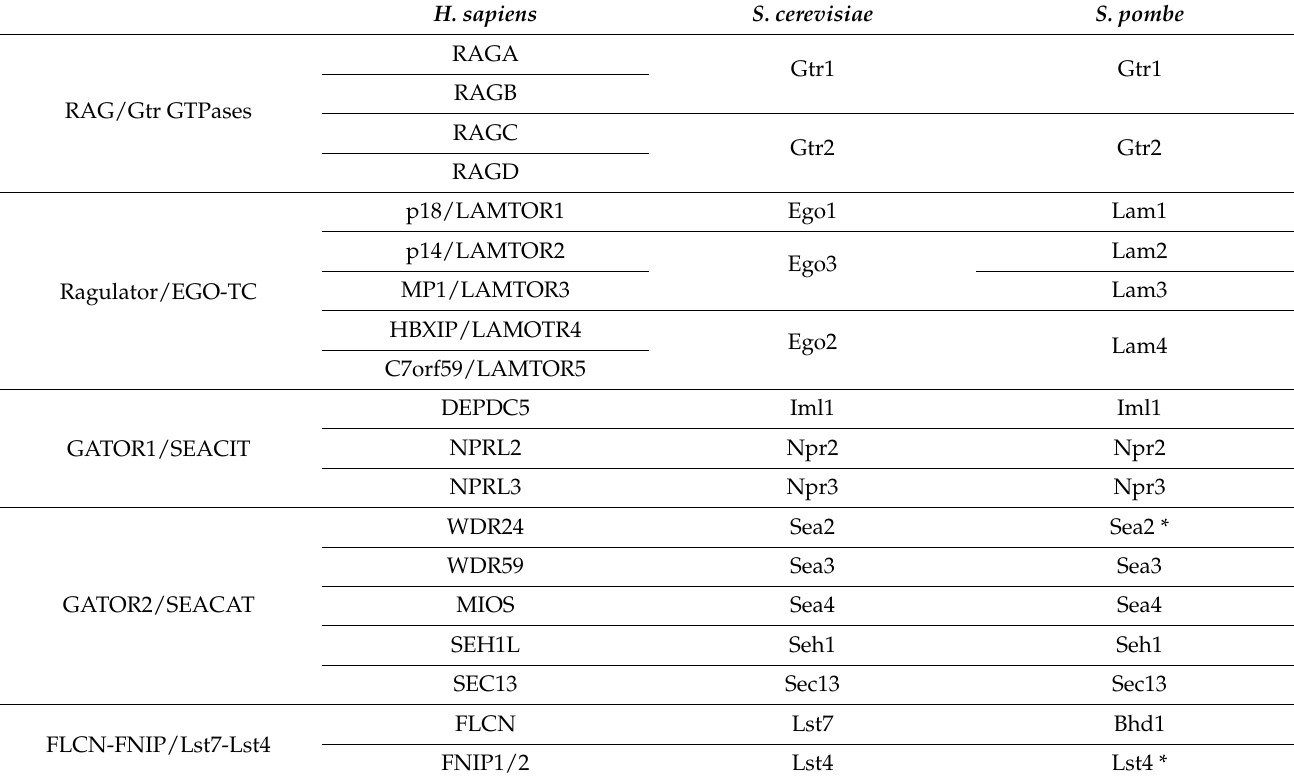
Table 1. Conservation of RAG/Gtr GTPases and their regulators in mammals, the budding yeast S. cerevisiae and the fission yeast S. pombe . Note that although Sea2 and Lst4 orthologs are present in fission yeast (marked with asterisks), their functional analysis has not been